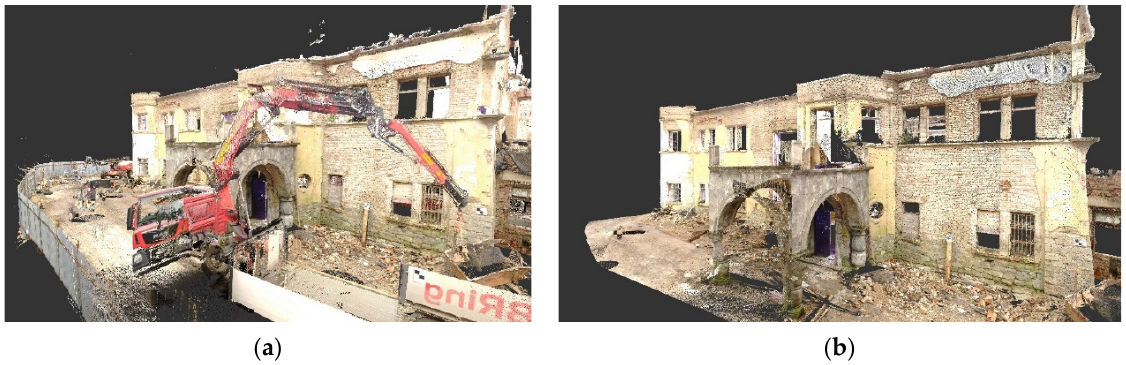
Figure 5. Comparison of raw ( a ) and denoised/filtered ( b ) point clouds.